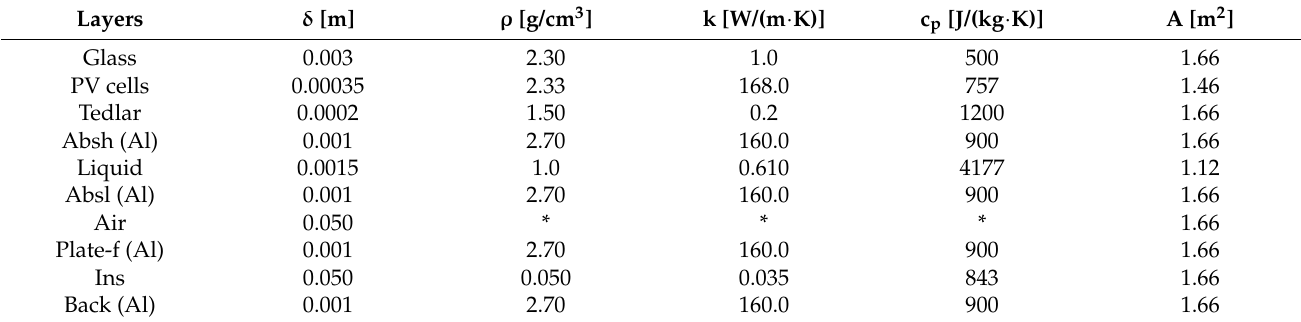
Table 2. Characteristic of the layers of the PV/T